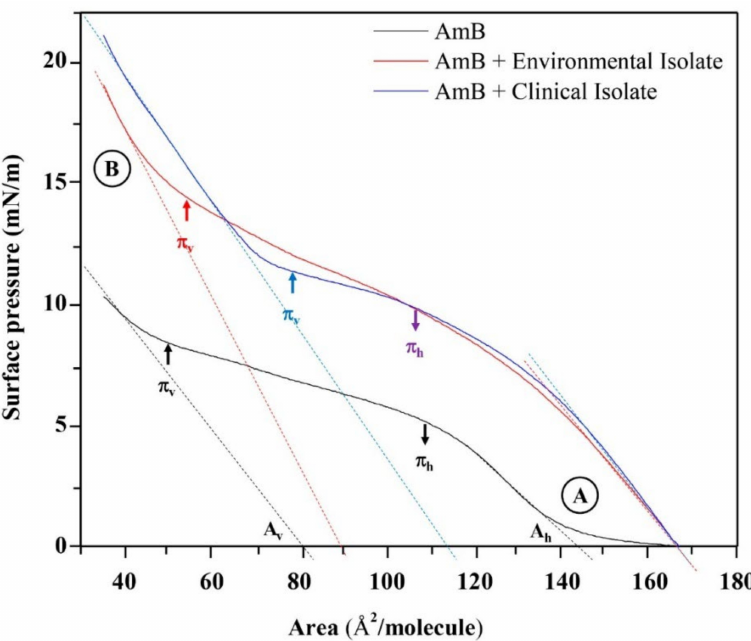
Figure 7. Surface pressure-area isotherms per molecule of Amphotericin B and the mixture of Amphotericin B with lipid extracts associated to the external surface of the cell wall of H. capsulatum mycelial phase extended on Tris buffer 5 mM, pH = 7.4. The linear adjustments to the linear positions of the extrapolated compression isotherms to surface pressure zero point to the specific molecular areas in a horizontal position (A h ) and in a vertical position (A v ). Concentrations are 13.737 g/L for environmental and 9.277 g/L for clinical extracts, respectively. ( A ) horizontal position (Ah); ( B ) vertical position